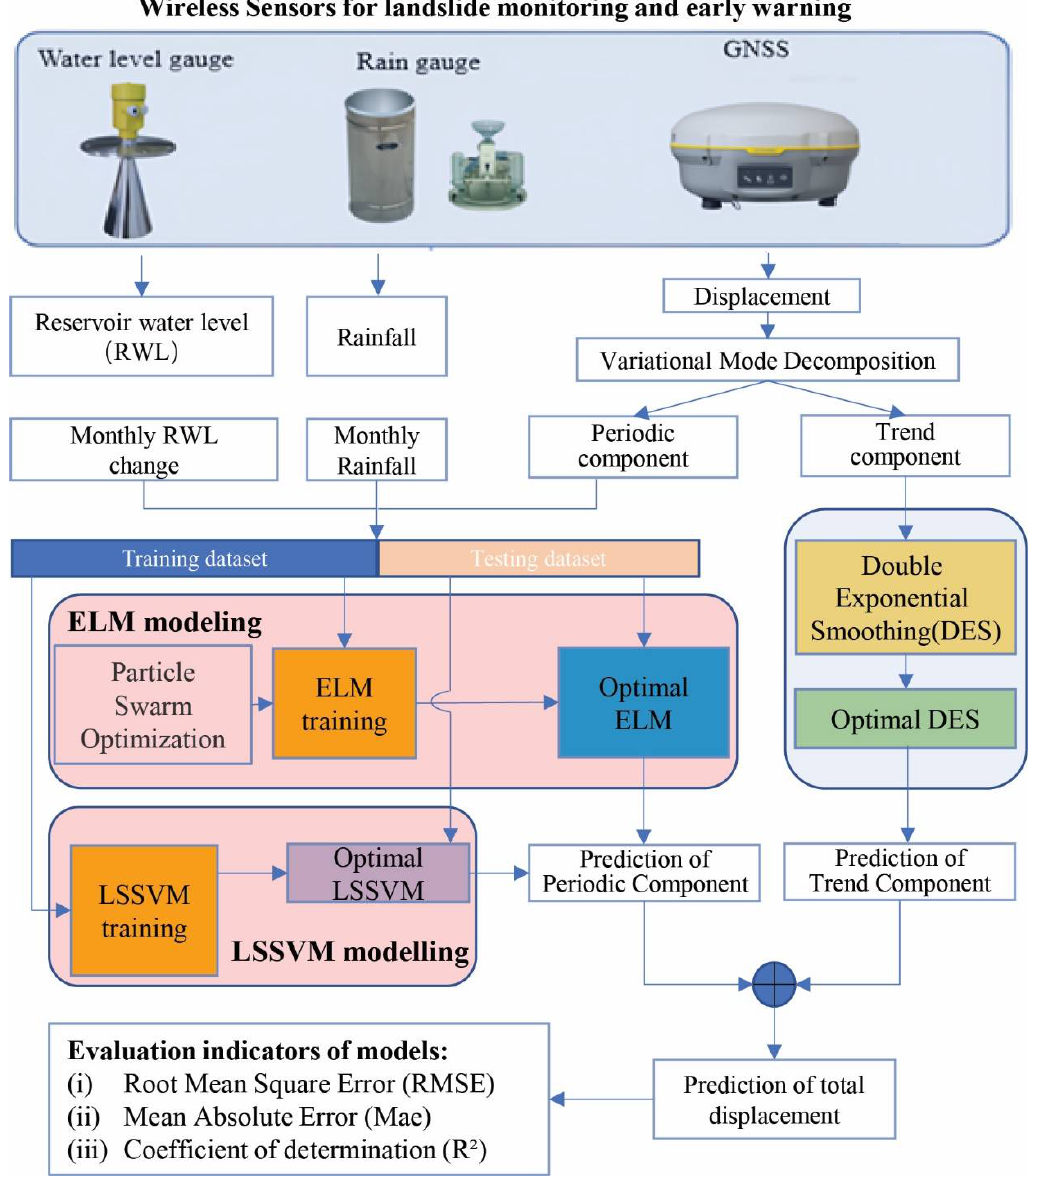
Figure 1. Procedures of landslide displacement prediction based on machine learning.